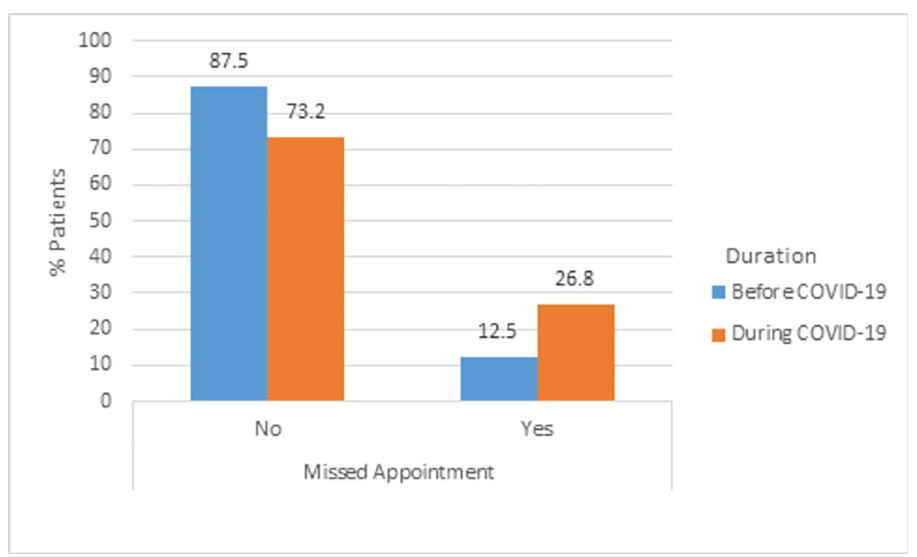
Fig 1. Missed appointment before COVID-19 pandemics and during the pandemics among common chronic disease patients in Amhara Region.